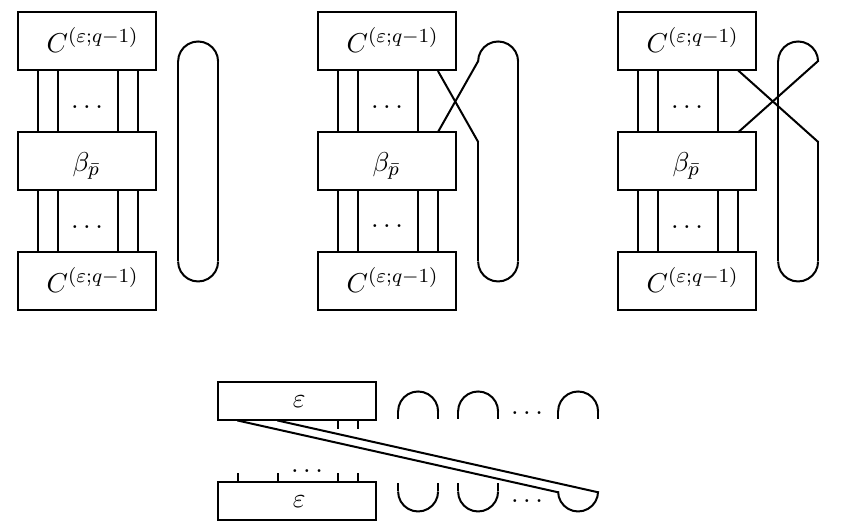
Figure 15 . Diagrammatic calculation of C ( (cid:12) ) for various (cid:12) 2 S N +2 q . The top row shows (cid:12) = (cid:12) (cid:22) p ; ( N + 2 q (cid:0) 2 ; N + 2 q (cid:0) 1) (cid:12) (cid:22) p and ( N + 2 q (cid:0) 2 ; N + 2 q ) (cid:12) (cid:22) p respectively, where (cid:12) (cid:22) p 2 S N +2 q (cid:0) 2 . The bottom row shows a (cid:12) with (cid:12) ( N + 2 q (cid:0) 1) = 1 and (cid:12) ( N + 2 q ) = 2. These two values of (cid:12) are enough to ensure C ( (cid:12) ) = 0, so the remaining parts of (cid:12) are not included in the diagram.